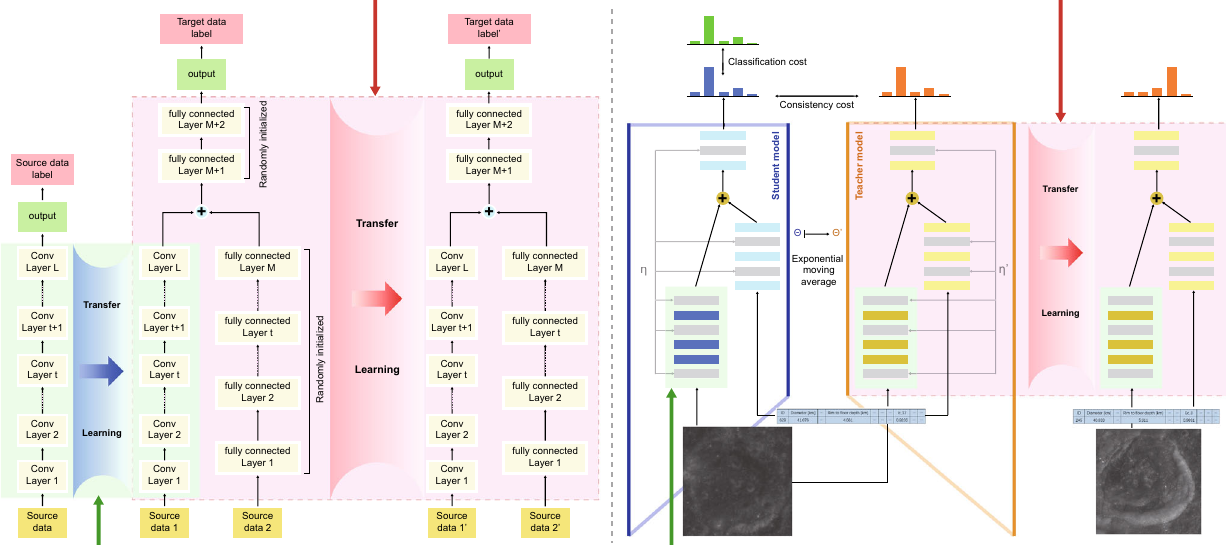
Fig. 5 Estimation of the age of lunar craters based on transfer learning (TL) with Chang ’ E-1 (CE-1) data and Chang ’ E-2 (CE-2) data. The fl ow chart demonstrates the two-stage crater classi fi cation approach based on TL. The two stages are separated by dotted lines. The left part is the TL process, and the right part shows the crater classi fi cation network structure. In the left part, the light green area indicates the fi rst-stage TL. The crater classi fi cation model includes two types of input data, i.e., images and attribute data. Thus, the model consists of two channels. One of the channels is based on the pre- trained deep convolutional neural networks (CNN) model on ImageNet (only convolutional layers, not including the top fully connected layers) for images, and the other is the feedforward neural network for attribute data. Meanwhile, a semi-supervised learning strategy, i.e., Meanteacher, is adopted to take advantage of a large number of newly identi fi ed craters. In the second TL stage, the two-channel classi fi cation model with the Meanteacher strategy is directly used for estimating ages with CE-2 data, as shown in the light pink area. There is no other training in the second TL stage. A series of deep CNN techniques are then used for the classi fi cation of crater ages with CE